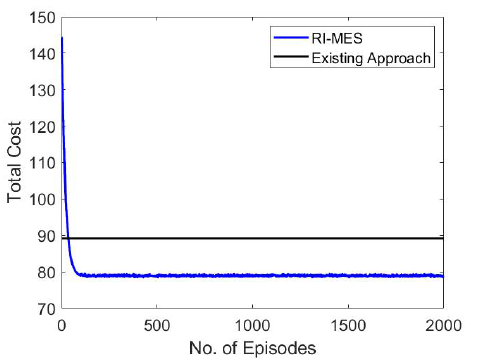
Figure 5. Comparative analysis: ( a ) Energy consumption by a particular end-consumer, ( b ) Energy consumption reduction with the proposed RI-EMS approach.